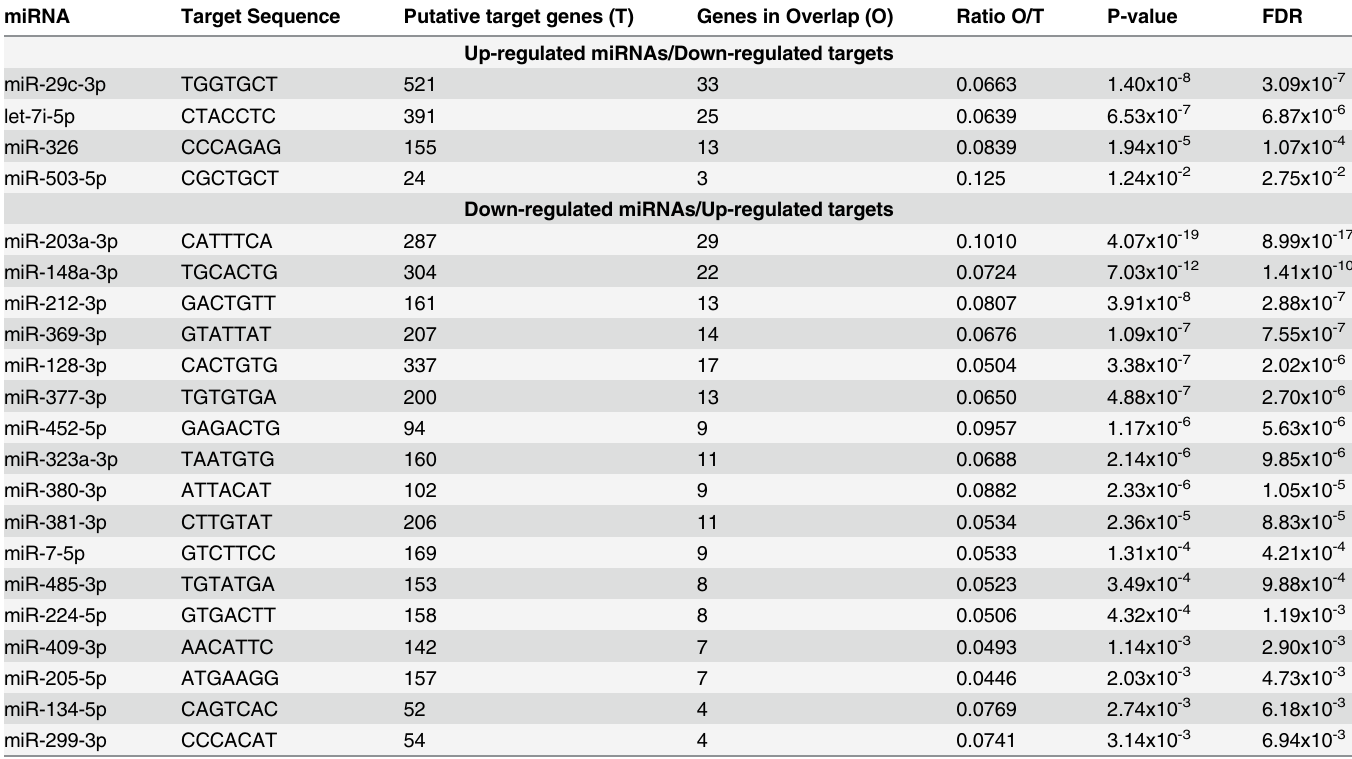
Table 1. miRNAs predicted to target differentially expressed mRNAs using